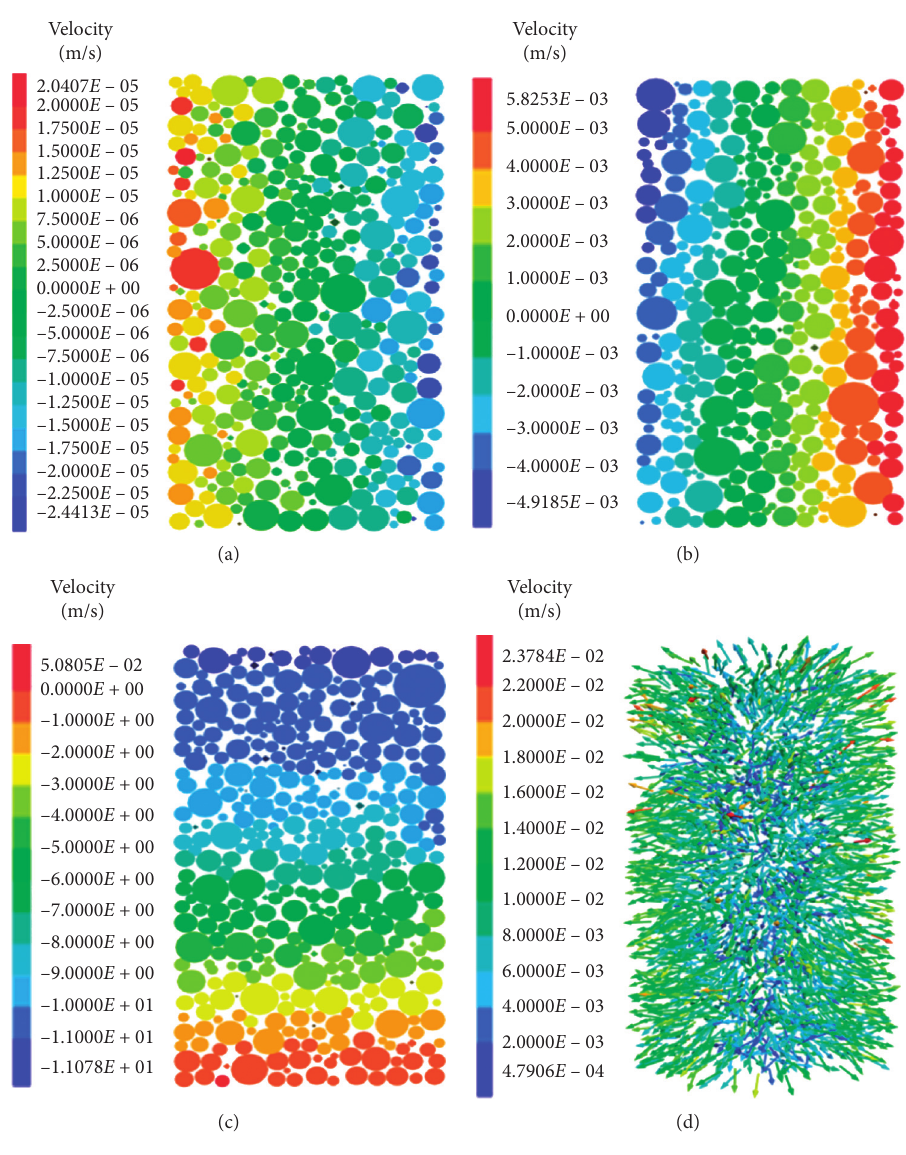
Figure 10: Internal velocity and displacement track of soil particles. (a) Velocity in X axis. (b) Velocity in Y axis. (c) Velocity in Z axis. (d) Particle displacement